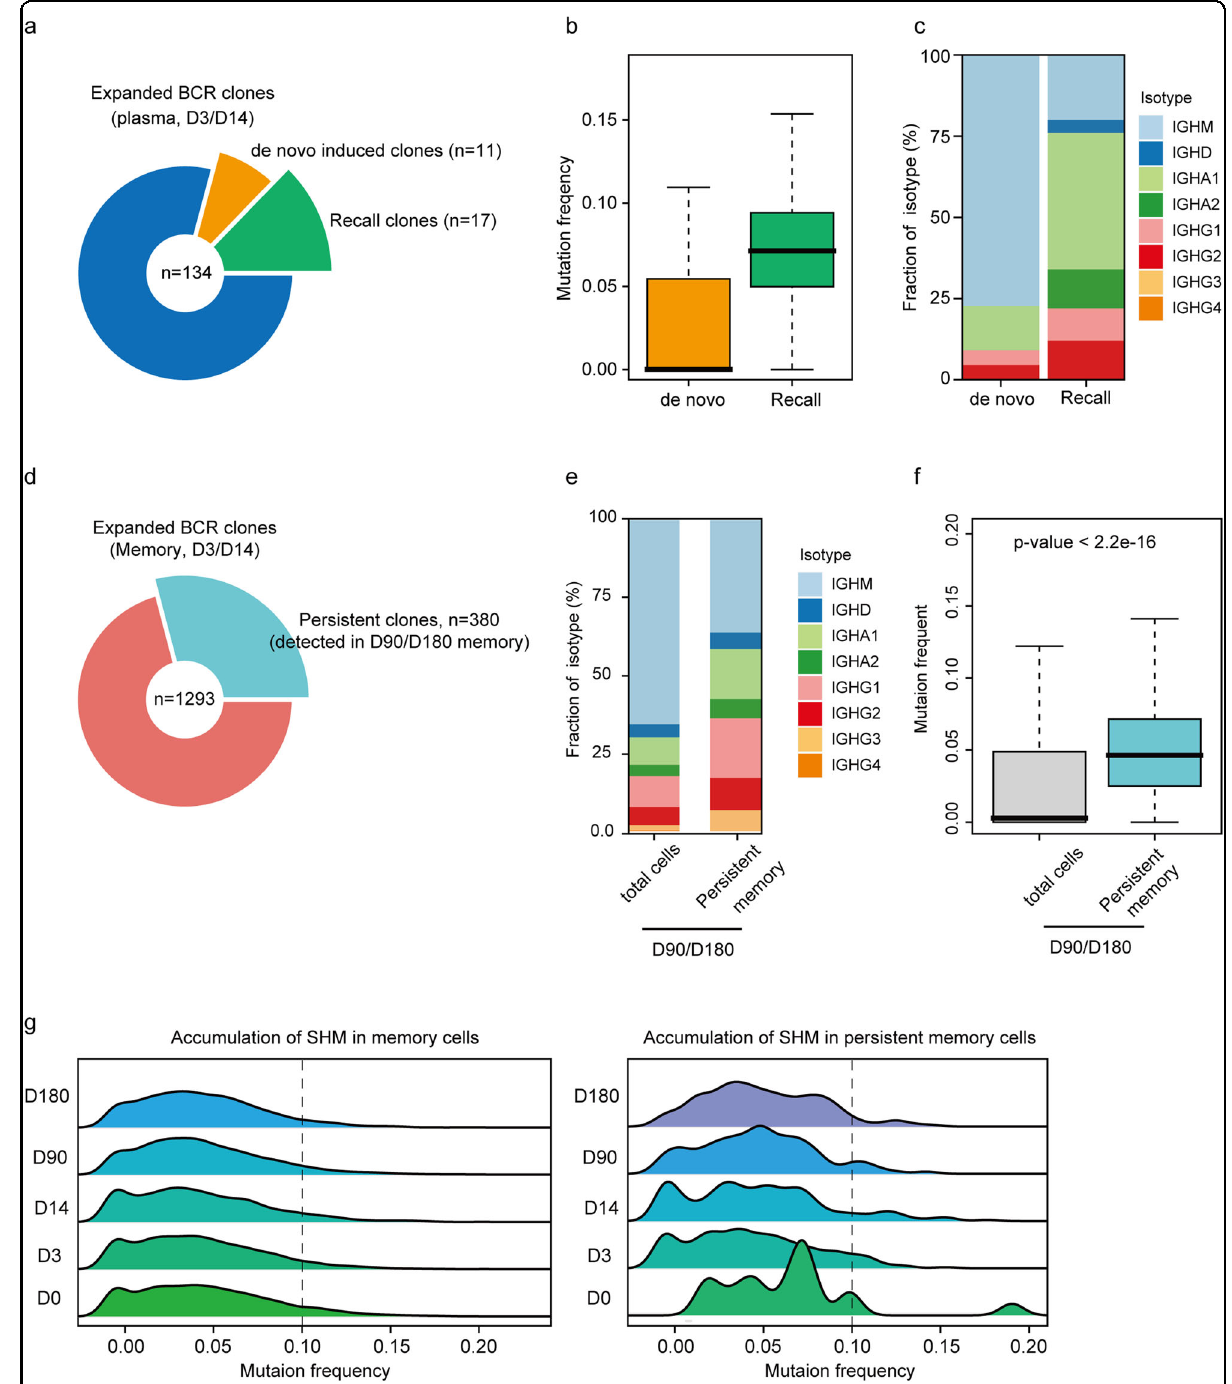
Fig. 4 Clonal expansion and persistence of B cells. a Pie plot shows that 11/134 expanded BCR clones detected in D3/D14 plasma cells were derived from naïve B cell, named de novo induced clones, and 17/134 expanded BCR clones detected in D3/D14 plasma cells were derived from memory B cell, named recalled clones. b Boxplot shows the BCR mutation frequency of de novo induced clones and recalled clones. c Average proportions of BCR isotypes between de novo induced clones and recalled clones. d Pie plot shows that 380/1293 expanded BCR clones detected in D3/D14 memory B cells could be detected in D90/D180 memory B cells, named persistent clones. e Average proportions of isotypes of persistent clones compared with BCR clones detected at D90/D180. f Boxplot shows the BCR mutation frequency of persistent clones compared with BCR clones detected at D90/D180. g RidgePlot shows the accumulation of memory cells against booster